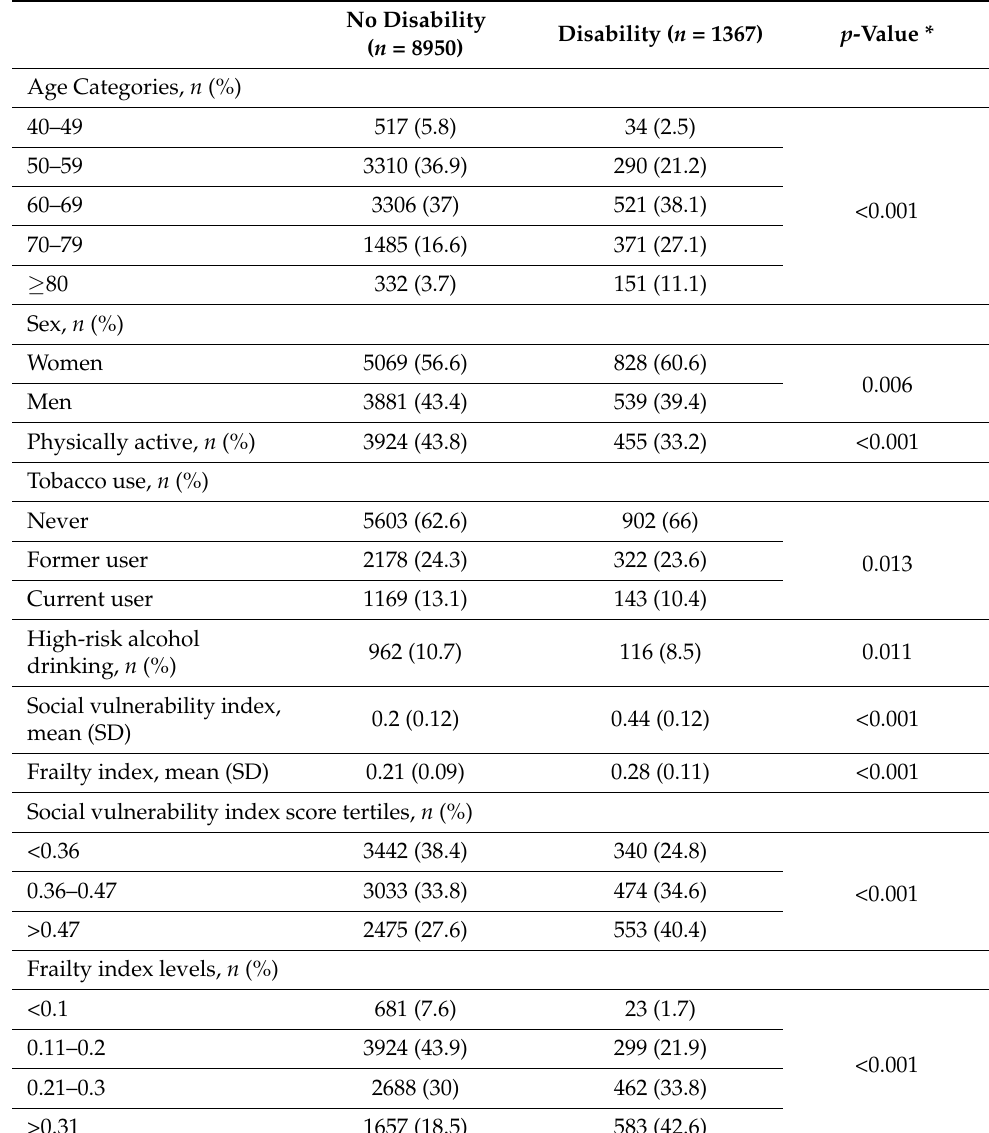
Table 3. Bivariate analysis for incident disability